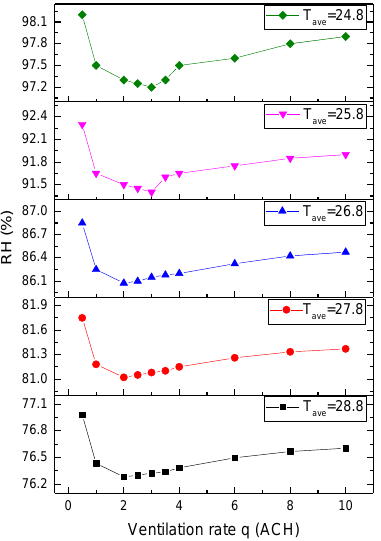
Figure 9. The highest indoor air RH under various outdoor air temperatures in the occupied home.